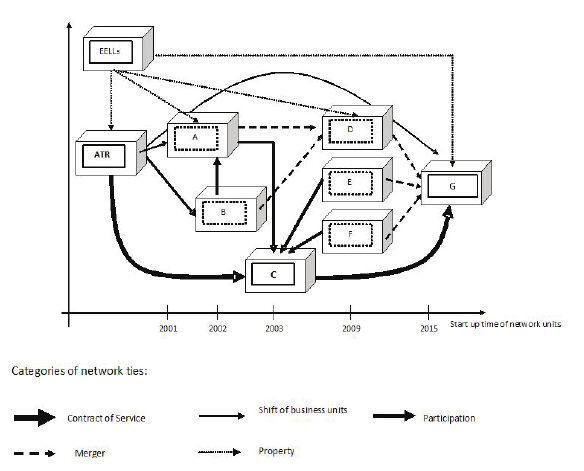
Figure 3. The evolution of the ATR network (updated to October